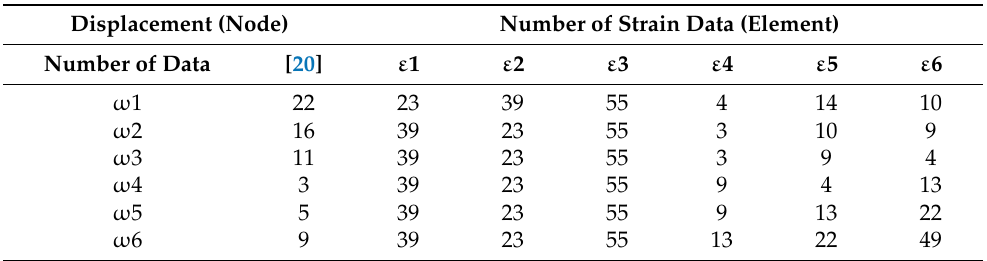
Table 9. Sensor location in the FEM model used for estimation (strain with displacement)—truss.